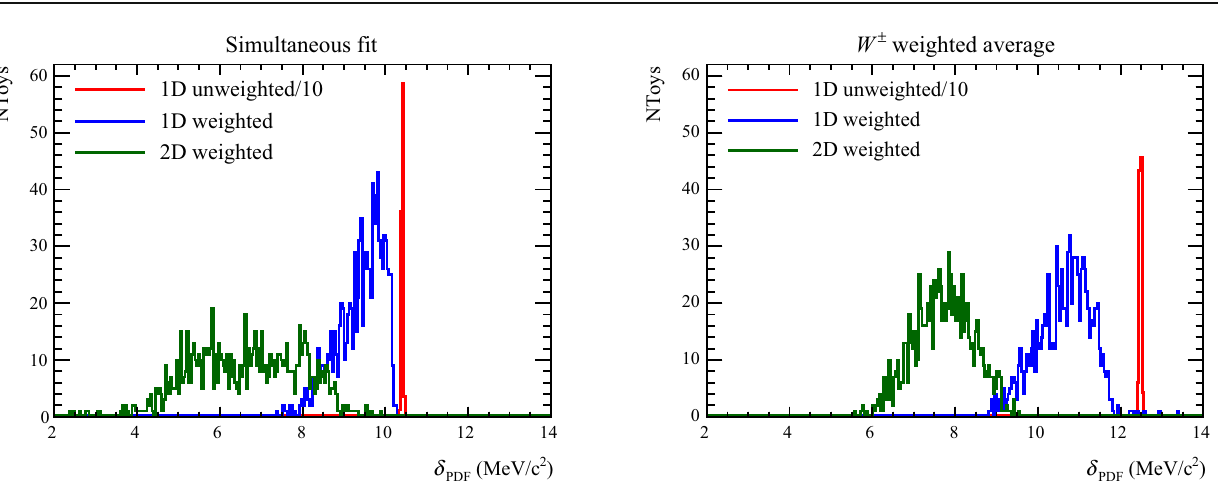
Fig. 14 PDF uncertainty as a function of the p centered around M W / 2) used in the simultaneous fit. The bands report the mean and the RMS of the distribution of the PDF uncertainty eval- uated for 1000 toy datasets. The η range is set to 2 < η < 4.5. In